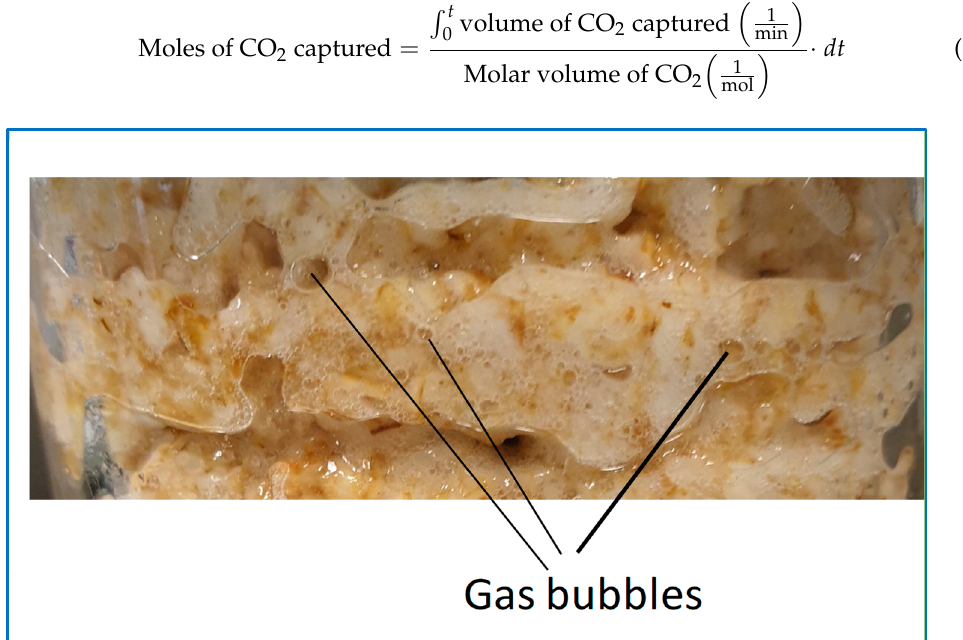
Figure 7. Picture of the gas flow through stacked layers of rice cake layers showing the trapped gas bubbles inside the rice structure.